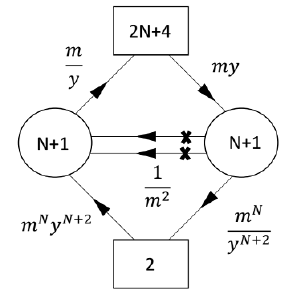
Figure 7. The theory we get after performing Intriligator-Pouliot duality on the two USp groups in the theory in (cid:12)gure 5 (b) when r = 2. Here there is a cubic superpotential along the upper triangle and an order N + 2 along the lower triangle. Additionally there are two singlet (cid:12)elds that (cid:13)ip the baryons made from the bifundamentals, which is represented by the ‘X’ drawn on the bifundamentals